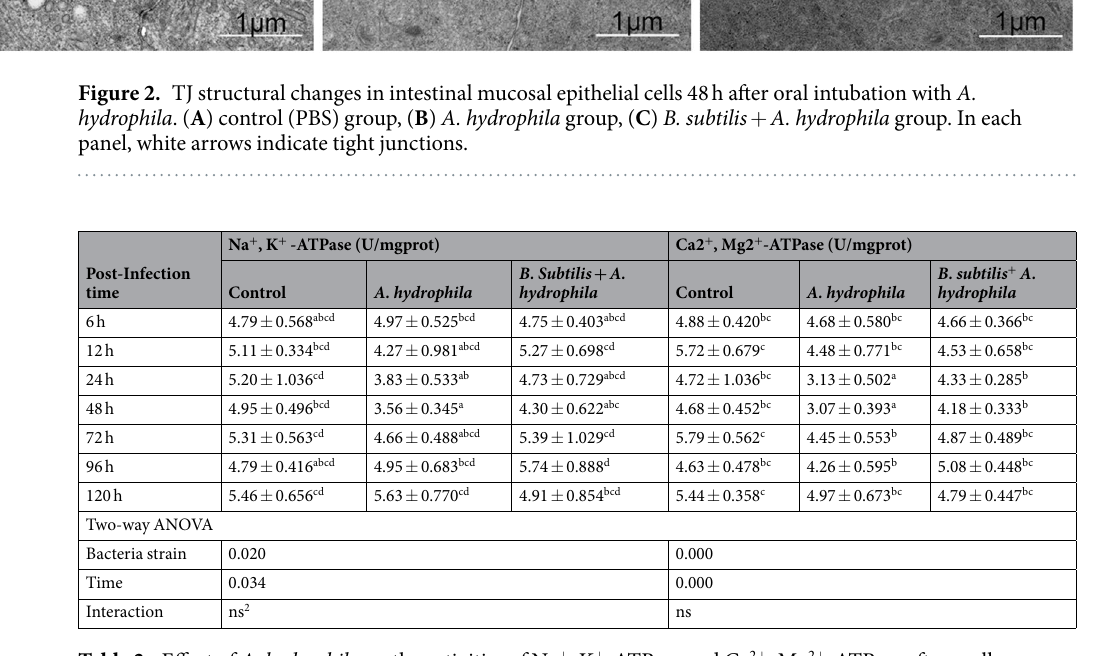
Table 2. Effect of A. hydrophila on the activities of Na + , K + -ATPase and Ca 2 + , Mg 2 + -ATPase after orally intubation with B. subtilis 1 . 1 Values are means ± SD (n = 6), and different superscripts in the same row are significantly different ( P < 0.05). 2 ns: no significant difference, the below is the